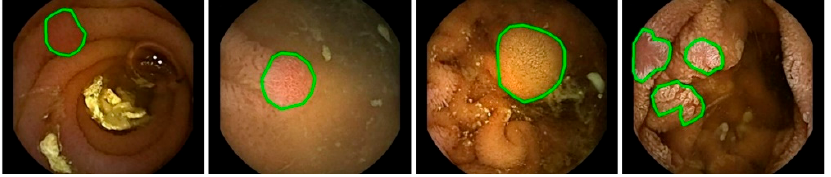
Figure 2. Images with ground truth polyps (marked in green) from wireless capsule endoscopy (WCE) videos.